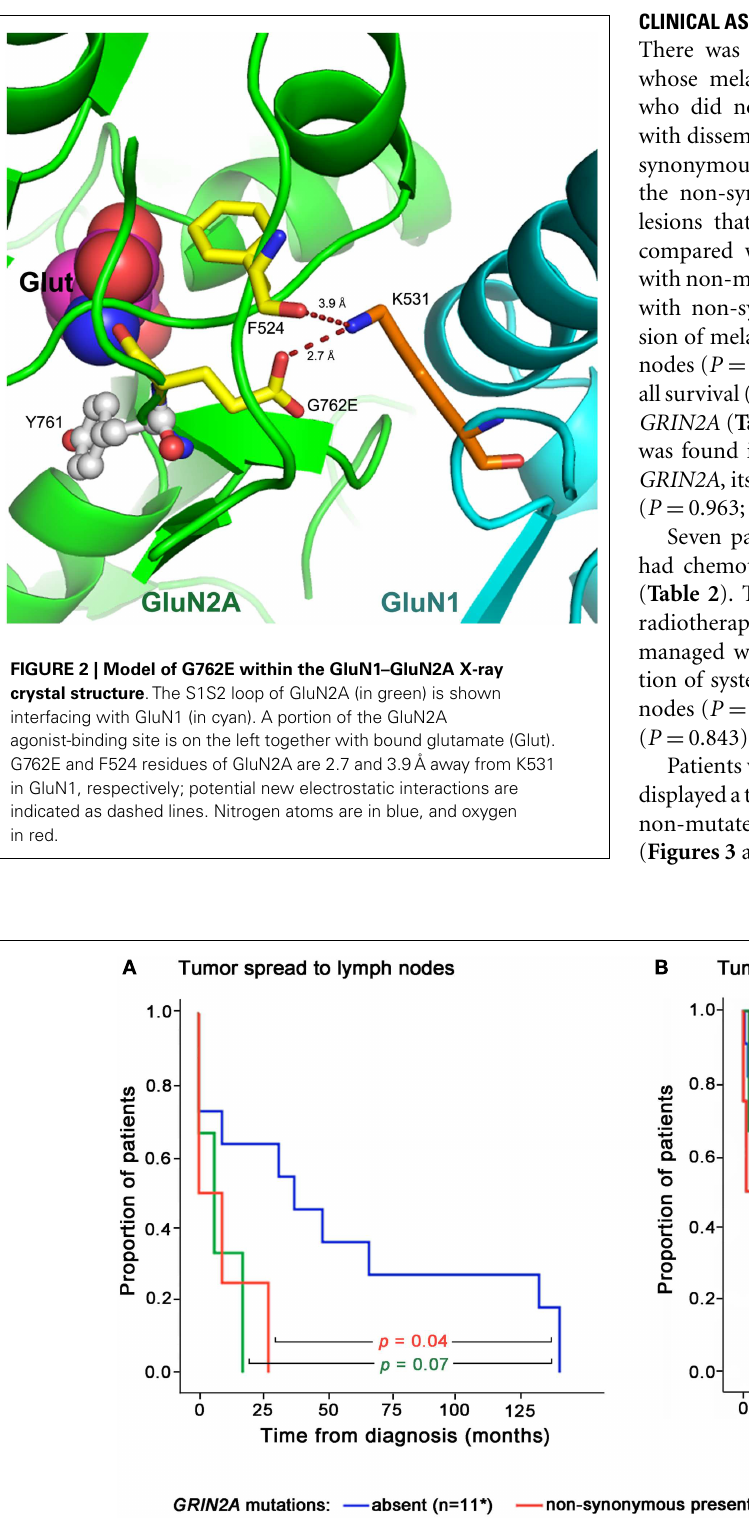
FIGURE 3 |Times of disease progression from diagnosis to lymph node (A) or distant organ (B) metastases for individual patients according to the presence or absence of GRIN2A mutations . Levels of statistical significance are shown. *Progression data for one patient with non-mutated GRIN2A was not